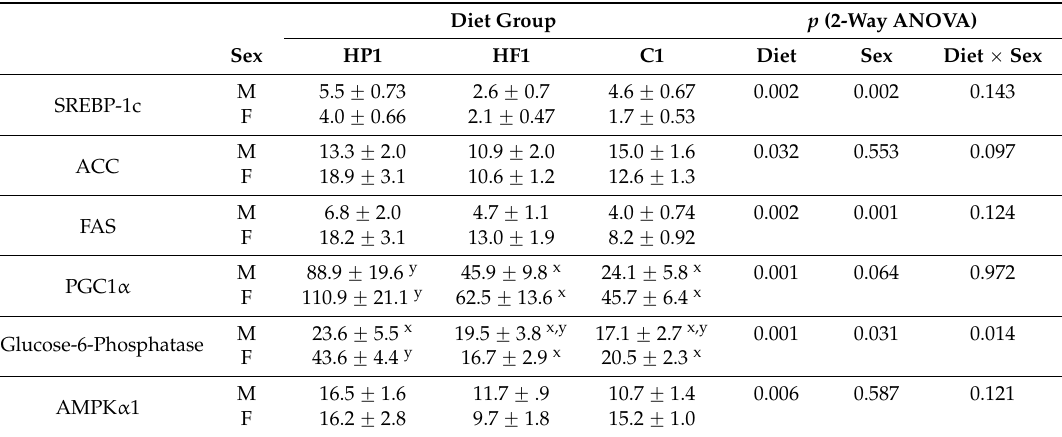
Table 4. Hepatic gene expression in the offspring of dams fed a control, high-protein or high-prebiotic fiber diet during pregnancy and lactation and then re-matched to their respective diets in adulthood. Diet Group p (2-Way ANOVA) Sex HP1 HF1 C1 Diet Sex Diet ˆ Sex